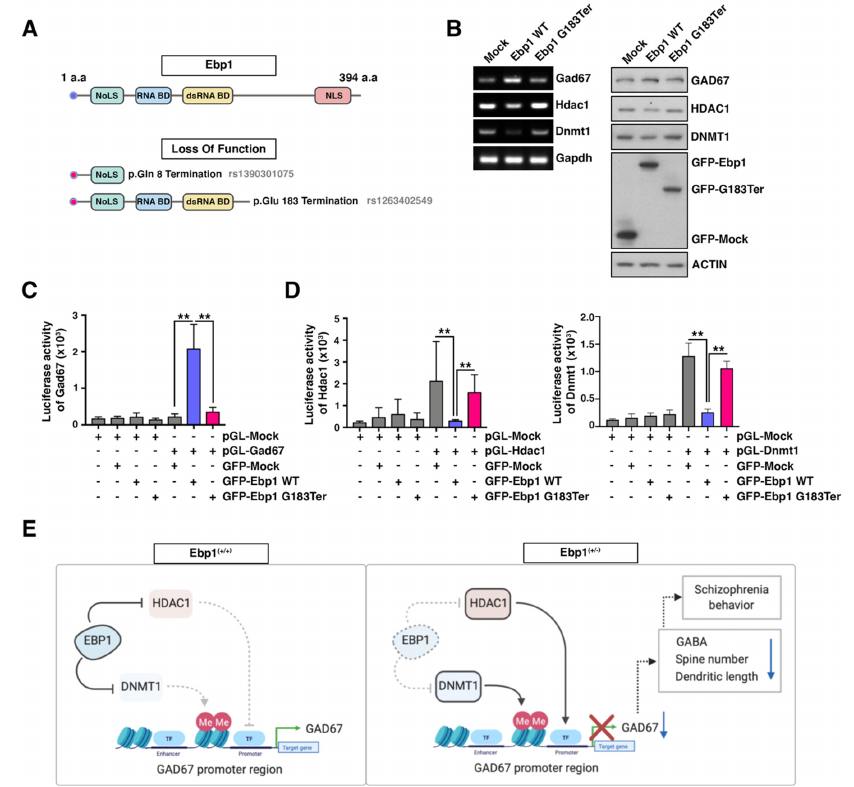
Figure 6. The loss of function/missense mutation of Ebp1 gene decreases GAD67 expression and 345 disturbs epigenetic control. ( A ) Schematic presentation of two of loss of function mutations, mutation 346 to stop codon, from SZ patients is shown. ( B ) RNA and protein expression levels of Gad67, Hdac1 347 and Dnmt1 were measured in transfected Ebp1 ( − / − ) MEF cells. GFP-mock, Ebp1 WT, or Ebp1 G183Ter 348 constructs were used for transfections. The RNA expression was tested using qRT-PCR with specific 349 primer sets. The protein level was measured using IHC with anti-GAD67, HDAC1. and DNMT1 350 antibodies. ( C ) Ebp1 ( − / − ) MEF cells were co-transfected with pGL-Gad67 promoter along with control 351 or Ebp1 WT, G183Ter mutation construct plasmids. Luciferase activity of GAD67 was measured using 352